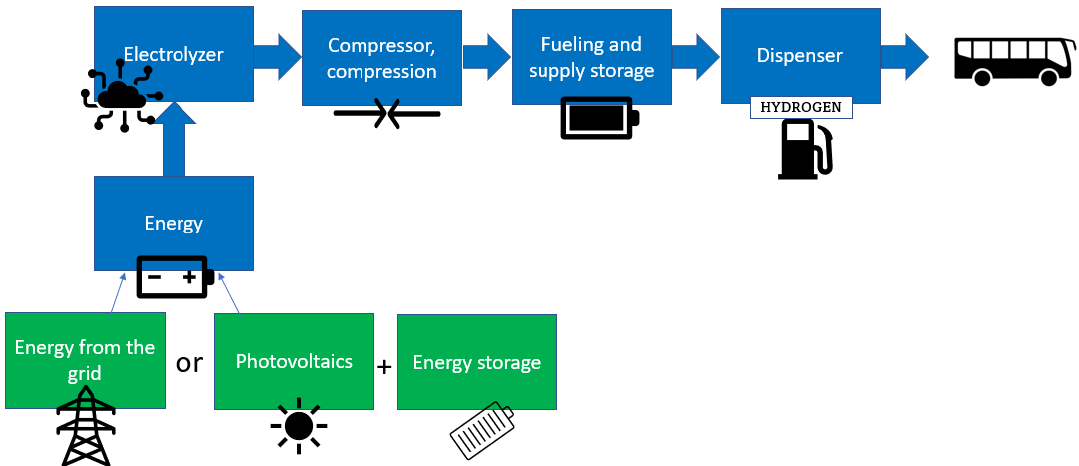
Figure 1. The process of generating hydrogen energy to supply buses with fuel [own